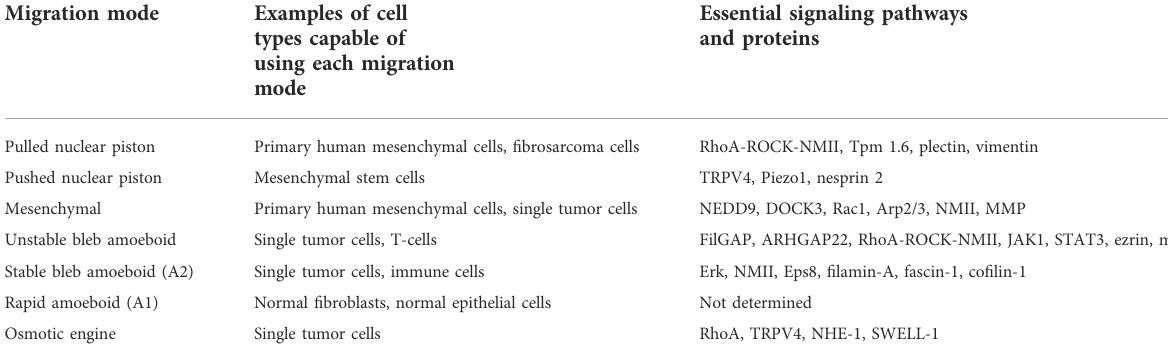
TABLE 2 Cell types and signaling pathways associated with each mode of single cell